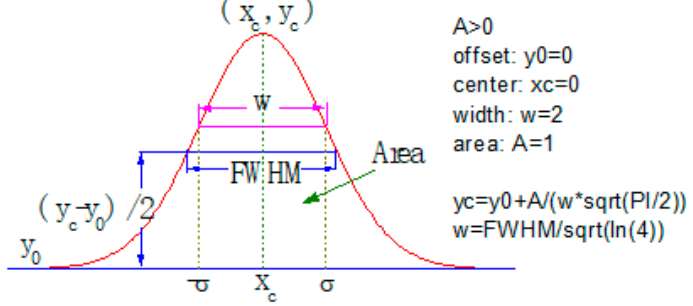
Figure 5. Modified Gaussian distribution curve.